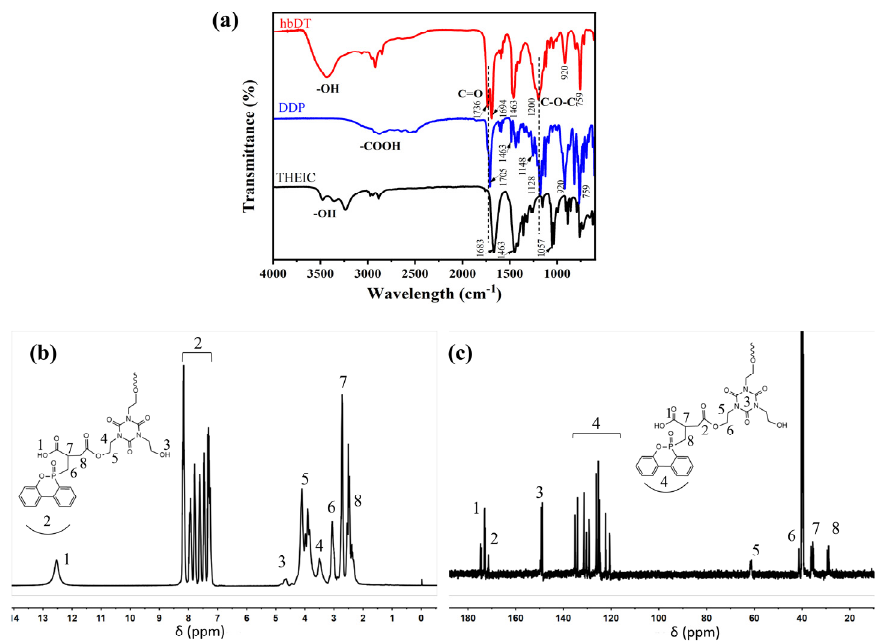
1 H NMR and ( c ) 13 C NMR spectra of